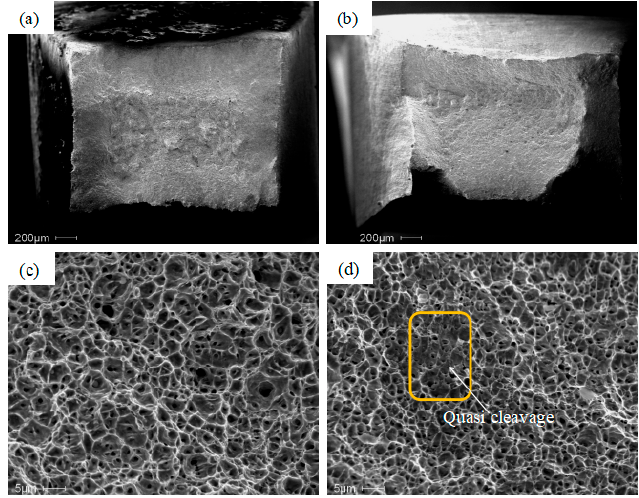
Figure 19. Fracture morphology of the tensile specimens: ( a , b ) Macroscopic fracture morphology of the transversal and longitudinal specimens; ( c , d ) typical fracture features of the transversal and longitudinal specimens.